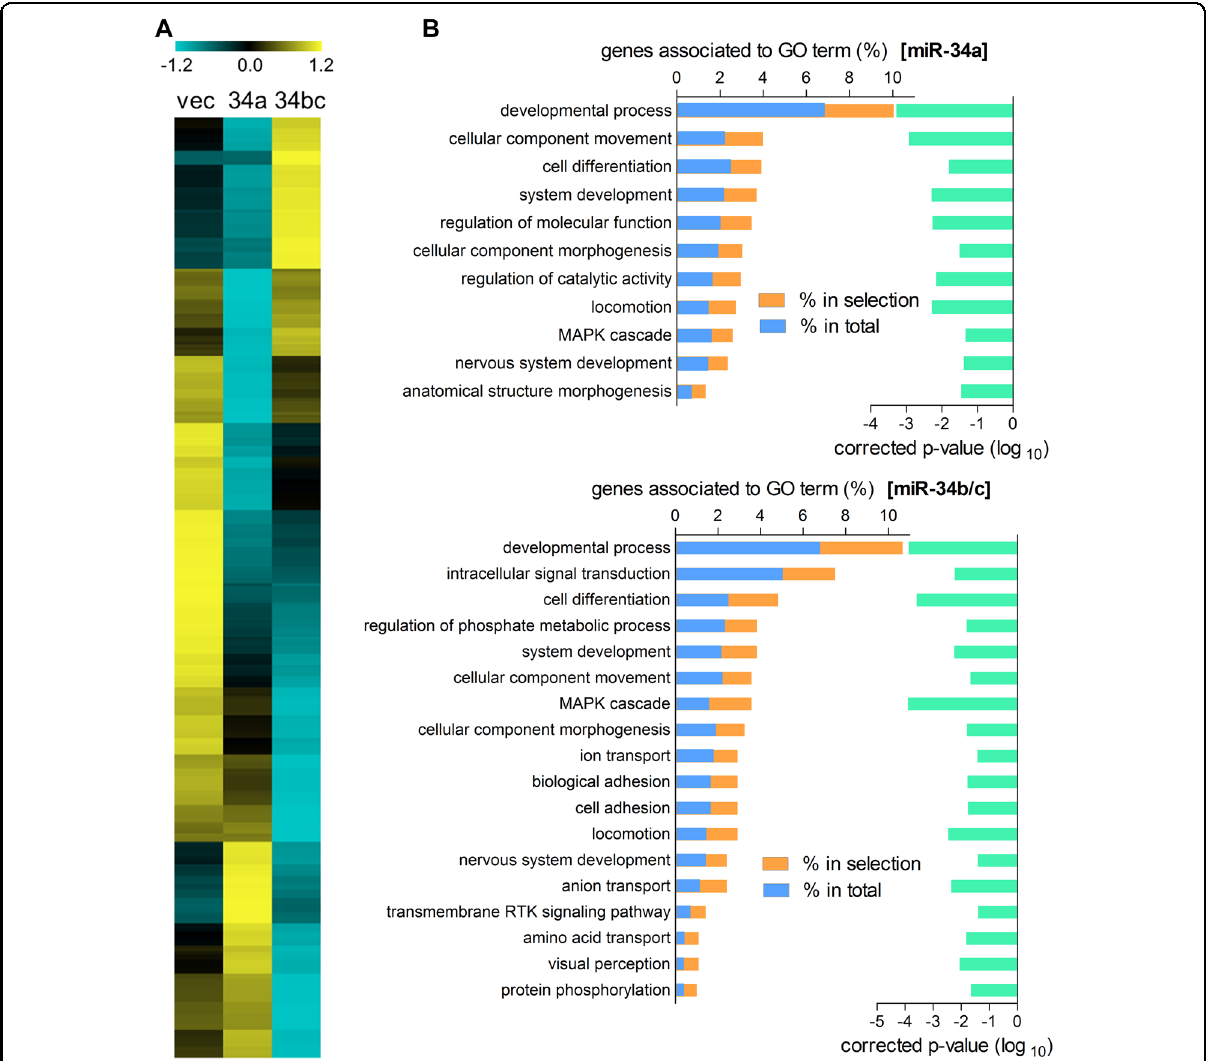
Fig. 5 MiR-34a and miR-34b/c have different effects on target gene expression. a Heatmap of differentially expressed genes (fold change ≥ 2) in miR-34-transduced 344SQ cells compared with those of vector-transduced cells, as identi fi ed by RNA sequencing. Yellow: increased expression; blue: decreased expression. b Gene ontology (GO) enrichment analysis (http://pantherdb.org) of differentially expressed genes in the miR-34- or miR- 34b/c-transduced 344SQ cells. Genes associated with the GO terms are shown in the left hand bars for differentially expressed genes (% in selection, orange) and for the total set of 22,262 genes (% in total, blue). The adjusted p -values (false discovery rate, FDR) are represented in the right hand bars (green). The GO terms with fold-enrichment ≥ 1.5 and FDR ≤ 0.05 were selected for the